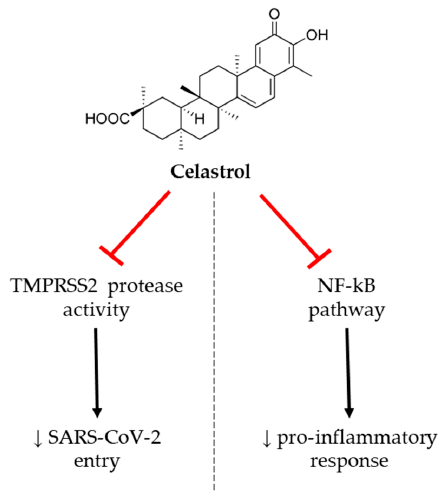
Figure 4. Anti-inflammatory activity of celastrol. NF- κ B: nuclear factor kappa B, TMPRSS2: transmembrane protease serine 2, ↓ : decrease.